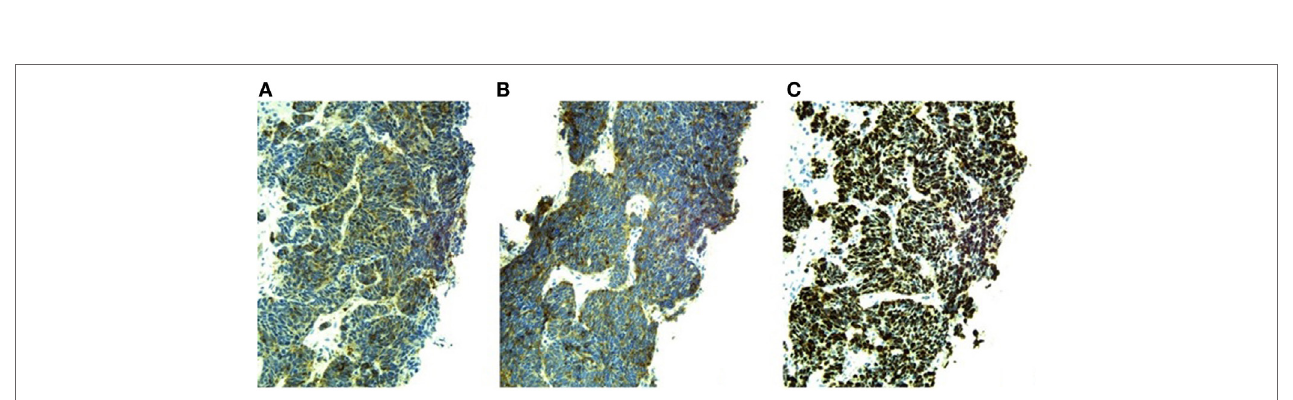
FIgURe 1 | Contrast-enhanced CT scans of chest, abdomen, and pelvis (a,B) showing renal, hepatic, and osseous metastases before chemotherapy (C,D) 2 weeks afterward showing significant interval improvement. (a) Hypoattenuated masses in the right renal pelvis and ureter (solid white arrow) and lytic lesions in the spine (black arrow). (B) Multiple hypoattenuated hepatic masses (dashed white